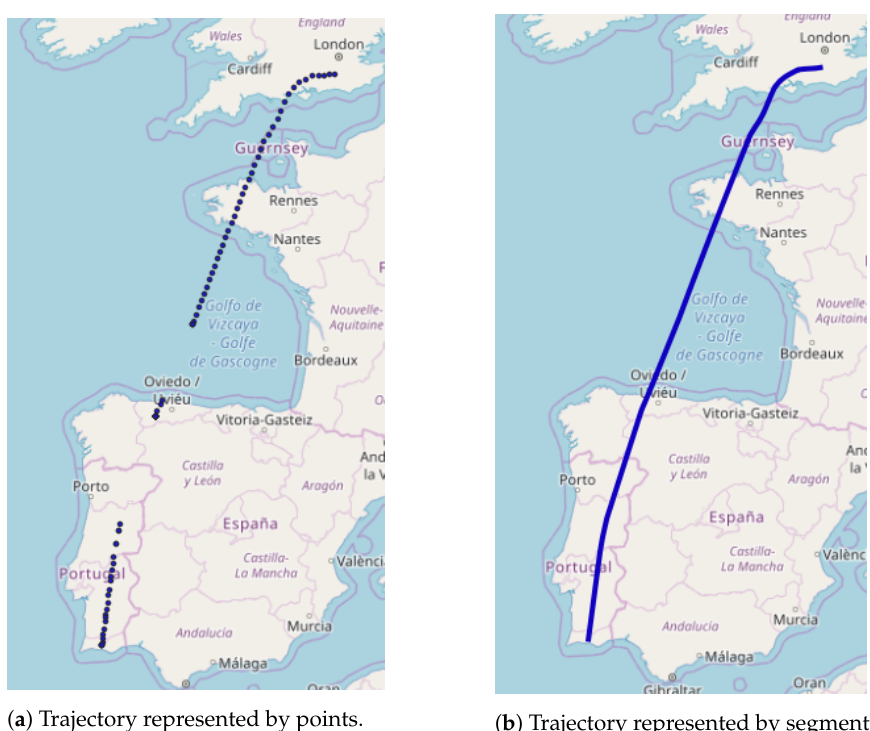
Figure 1. Trajectory plotted using points ( a ) or segments ( b ), shown in